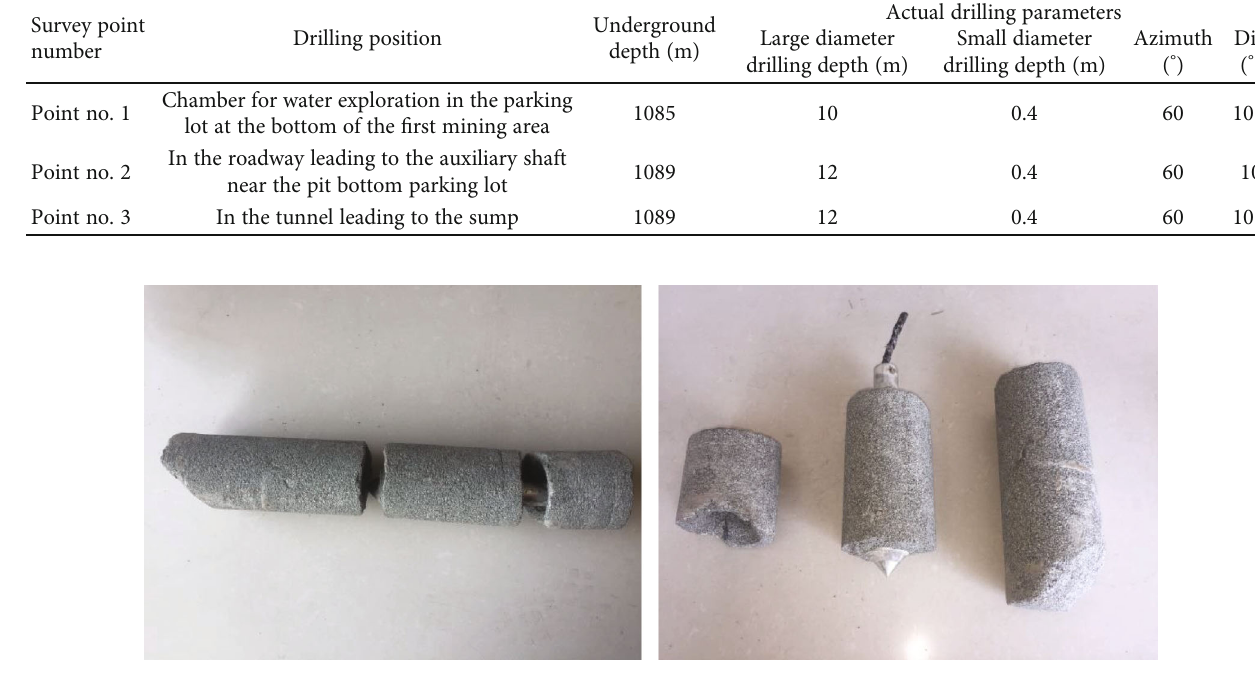
Figure 4: Core samples from some survey points.